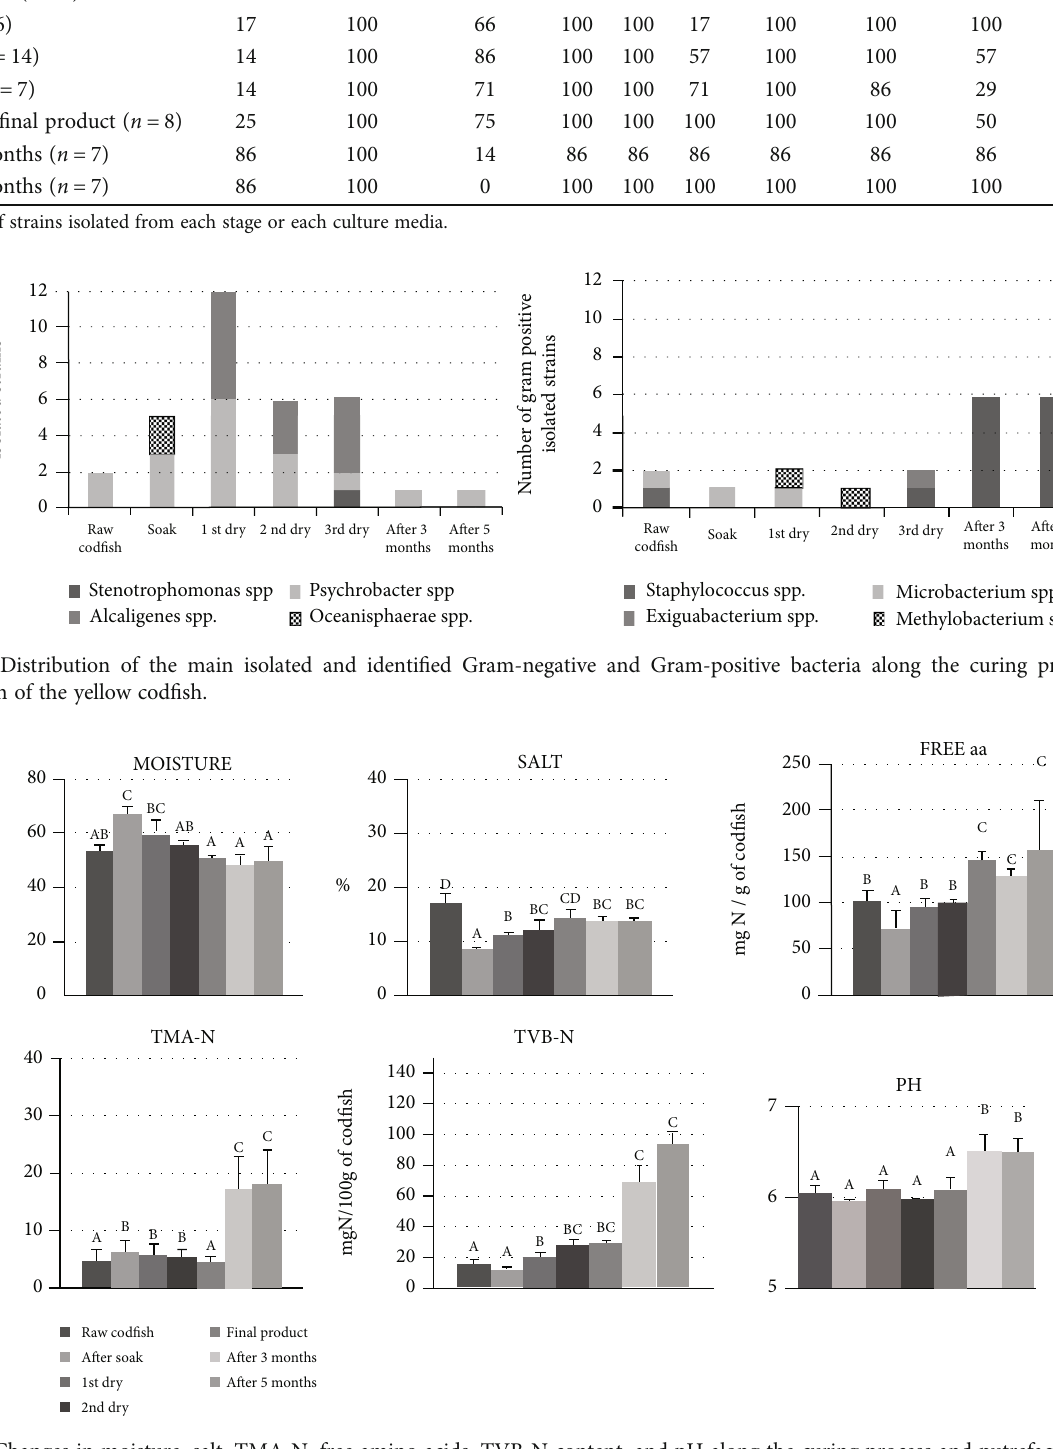
Figure 4: Changes in moisture, salt, TMA-N, free amino acids, TVB-N content, and pH along the curing process and putrefaction of the product. Di ff erent letters indicate that there are statistically signi fi cant di ff erences between the stages ( p < 0 : 05